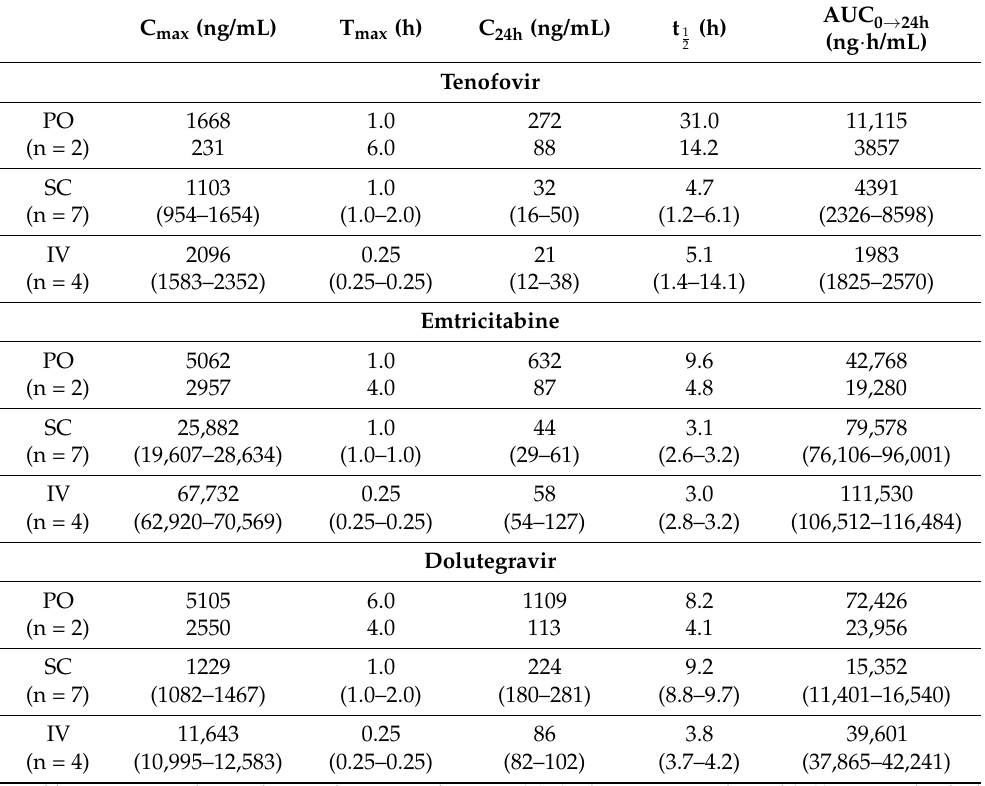
Table 1. Tenofovir/emtricitabine/dolutegravir single-dose pharmacokinetic